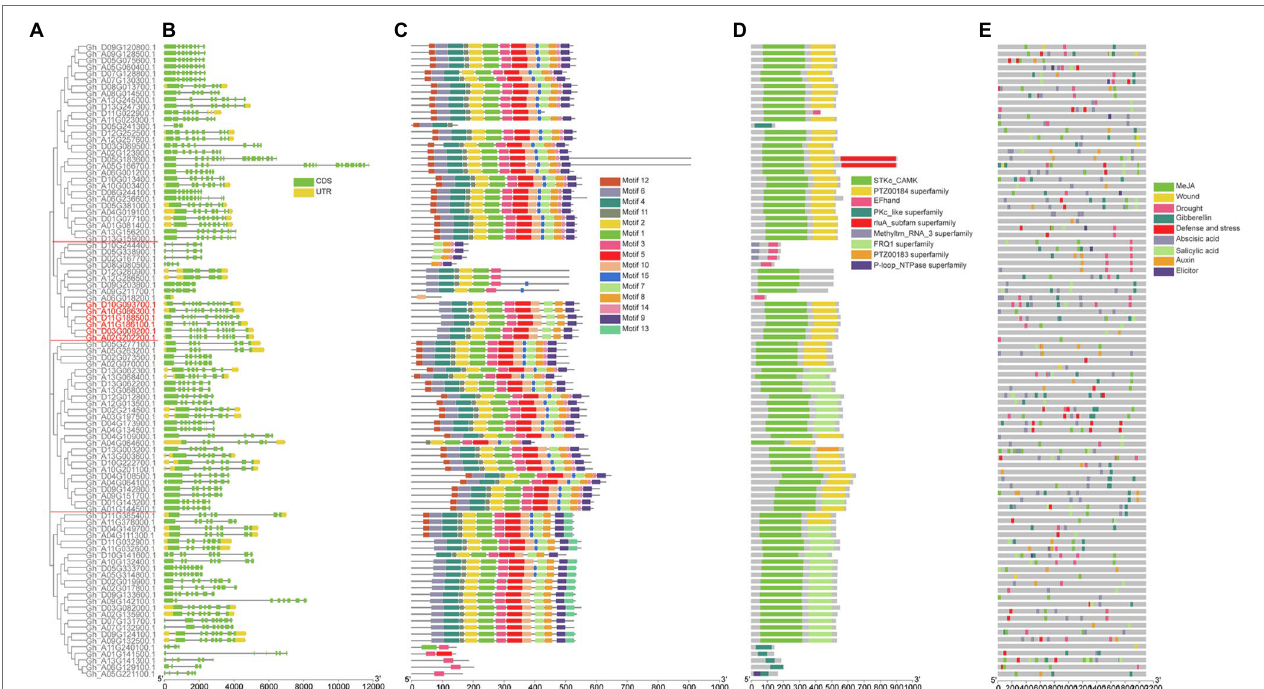
FIGURE 2 | Structural and motif analysis of cotton GhCDPK. (A) Phylogenetic relationships between GhCDPKs. The rootless phylogenetic tree was constructed by MEGAX with 1,000 replicates. GhCDPKs are divided into four clades. (B) Exon-intron structures of GhCDPK genes. The green box represents coding sequence (CDS), the yellow boxes represent Untranslated Regions (UTR), and the black lines represent introns. (C) Conserved motifs of GhCDPK proteins. There are a total of 15 conservative motifs in GhCDPKs, which are represented by different colors. The scale at the bottom shows the length of the protein. (D) conserved domain of GhCDPK protein. Nine different conserved domains were identified and indicated in different colours. (E) Cis-acting element prediction of GhCDPK genes. Online database PlantCARE was used to analyze cis-acting regulatory elements in the 2 kb promoter region upstream of all GhCDPKs. Cis-acting regulatory elements related to MeJA, wounding, drought, GA, defense, abscisic acid, salicylic acid, auxin and elicitor were